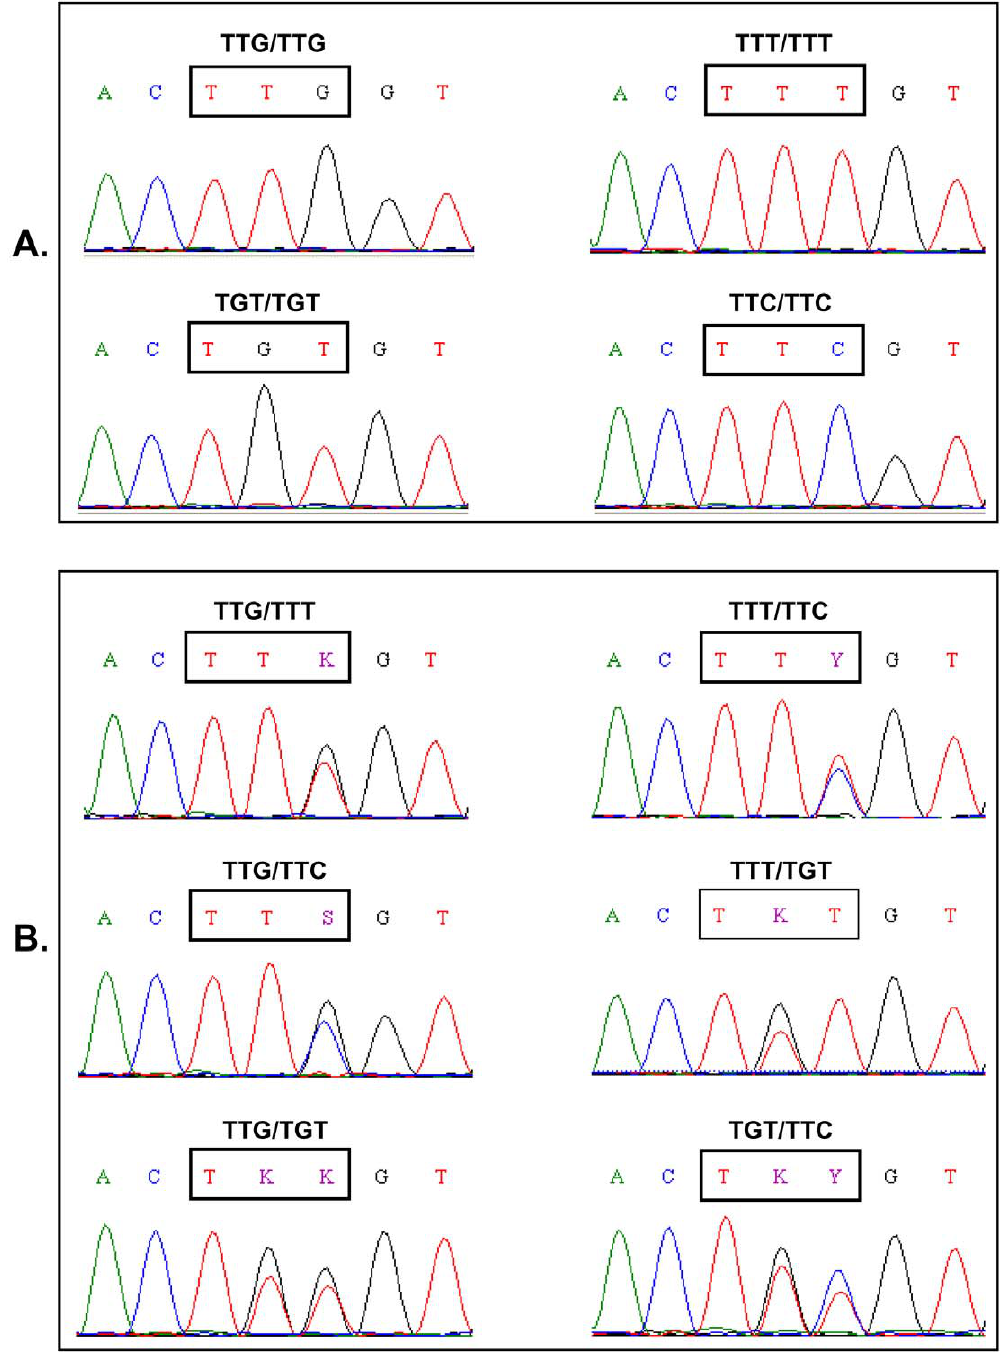
Figure 3. Examples of nucleotide sequence chromatograms of kdr genotypes detected in Anophelessinensis from China. The position at codon 1014 of the para -type sodium channel gene is indicated by a rectangle box. A: four types of homozygote genotypes detected; and B: six types of heterozygote genotypes detected (K=G/T; Y=T/C; S=G/C). doi:10.1371/journal.pone.0055475.g003 gene (Genbank acc. no. DQ334052). PCR products were directly 28S rDNA regions (D1 and D2) [46]. To determine point sequenced in both forward and reverse directions using the same mutations of the para -type sodium gene at positions 1014 and 918, primers. Direct sequencing was performed by Genewiz Inc (South we first amplified a 325 bp fragment of the para -type sodium gene Plainfield, NJ) on 150 field-derived mosquitoes. Based on data including position 1014, and then a 450 bp fragment including obtained from these individuals, allele specific amplification (AS- position 918 (Table 1). PCR primers were designed based on the An. sinensis sequences of the DIIS6 region of the para -type sodium PCR) primers were designed to detect four mutations (TTG,